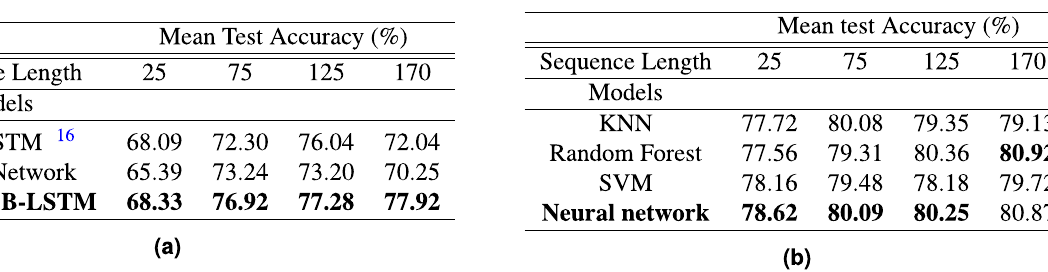
LSTM and the neural network, the proposed model obtained the highest prediction accuracies at every sequence length (see Table 1a). The best classification accuracy of our model was 78% at a sequence length of 170 s. These results indicate that EEG signals are strong predictors of the user’s mental state. Results from dataset 2 can be seen in Fig. 1b. In this scenario, it was observed that the mean prediction accuracy is not as correlated with the input sequence length as in dataset 1. Results from the proposed model for this dataset (neural network) showed a 2% increment in the accuracy by increasing the sequence length from 25 to 75 s. After, 75 s improvements in prediction accuracy are less than 1%. Compared to the tested traditional machine learning models, our classifier obtains better performance for every sequence length except 170 s. The best classification accuracy of our proposed model is 80.25% with a sequence length of 125 s. Table 1 summarizes all the results from the computational experiment. Physiological analysis of EEG features. Figure 2 shows the resulting scalp topographical maps of the EEG spec- tral features from dataset 1. In these plots, only channels having a difference of more than 0.2dB between the